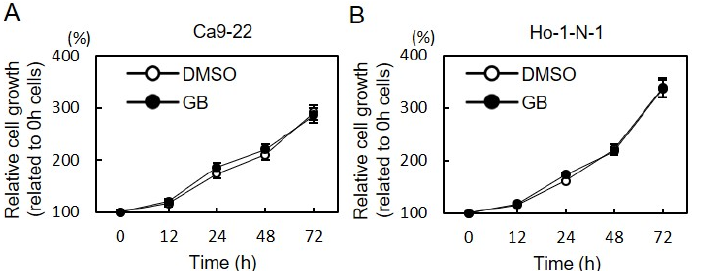
Figure 6. Effect of GB on cell proliferation. ( A , B ) To determine the effect of GB on cellular proliferation, OSCC cells were seeded in 96-well plates at a density of 1 × 10 4 cells/well and treated with GB (200 µ M) or DMSO for 24 h, followed by cellular viability assay. The cells were counted at the indicated times. There was no significant difference in OSCC cell proliferation after treatment with GB (Ca9-22 ( A ) and Ho-1-N-1 ( B )). GB, ginkgolide B; OSCC, oral squamous cell carcinoma.